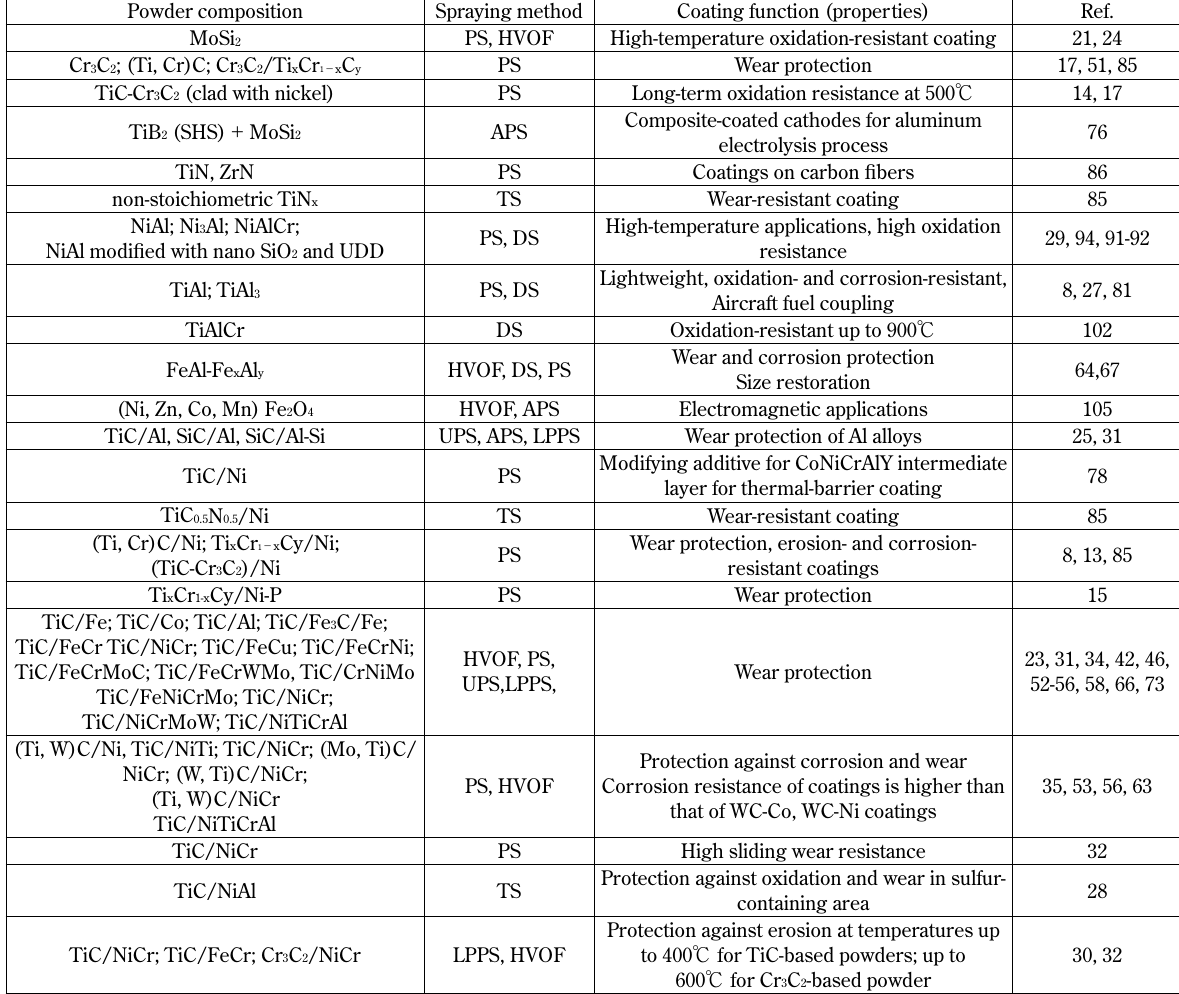
Table 4 SHS powders for thermal spraying Powder composition Spraying